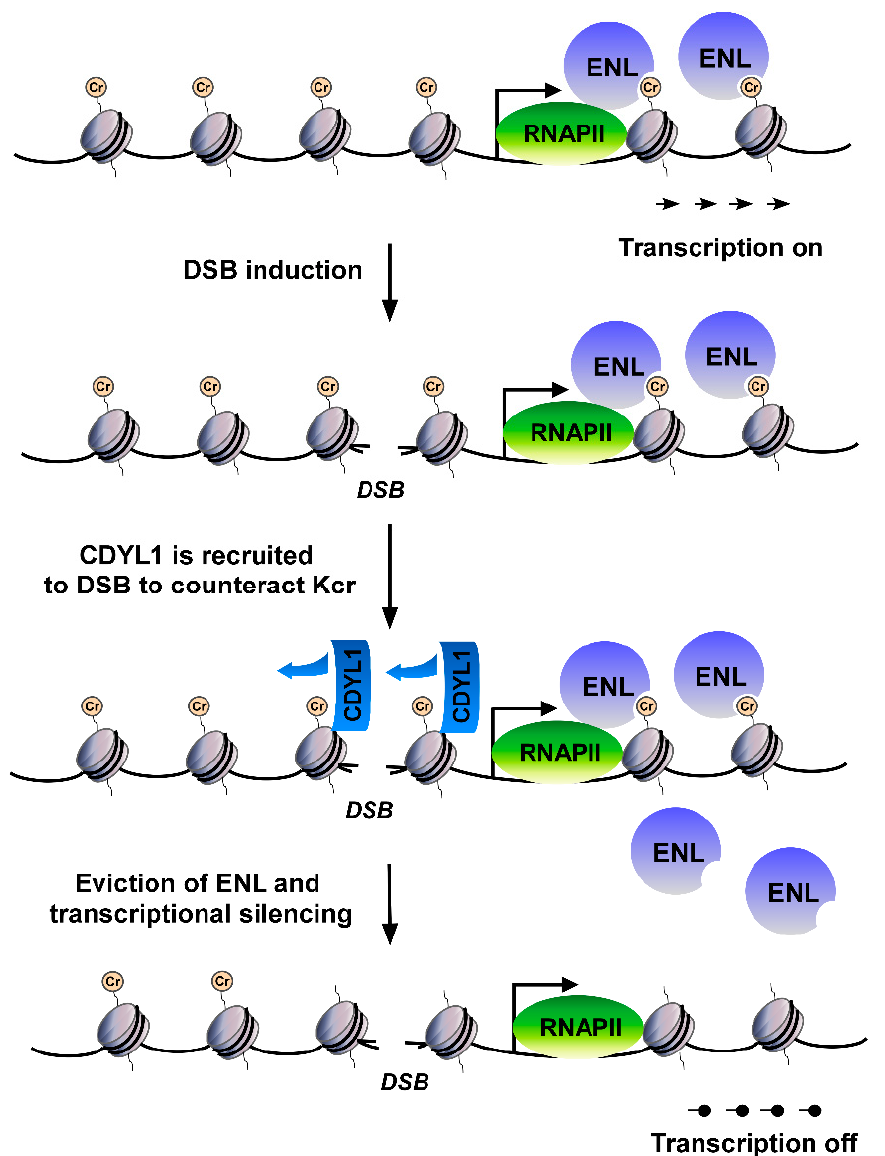
Figure 1. Functions of histone Kcr in DSB-induced transcriptional silencing. CDYL1 is rapidly recruited to the DSB sites when DSBs occur and counteracts the histone Kcr in the damaged region via its crotonyl-CoA hydratase activity. This activity leads to the eviction of the transcription elongation factor ENL and transcriptional silencing.